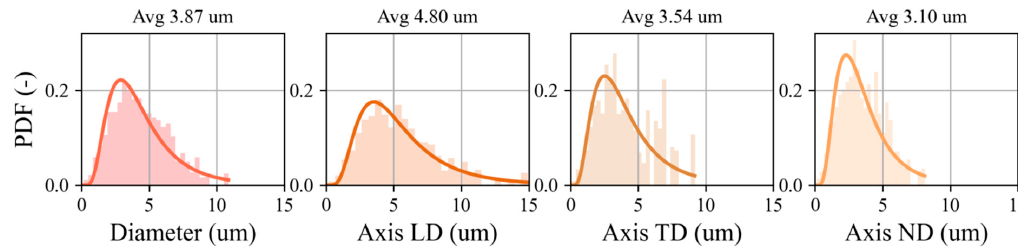
Figure 2. Histograms of grain sizes and equivalent ellipsoid axes and fitted lognormal distributions (continuous lines). On top of each graph, the average value is displayed.